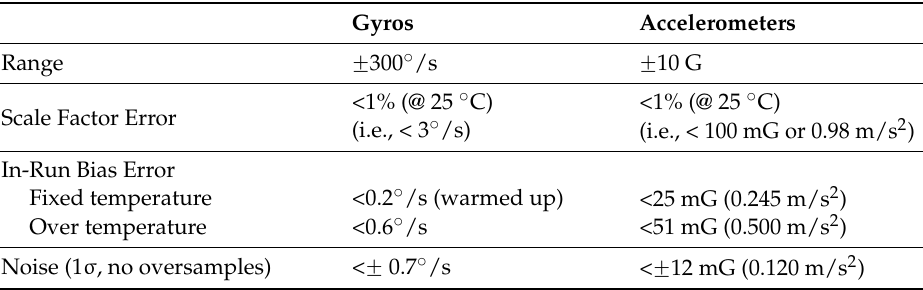
Figure 13; and comparison of Euler angle estimation results for CKF versus FACKF is shown in